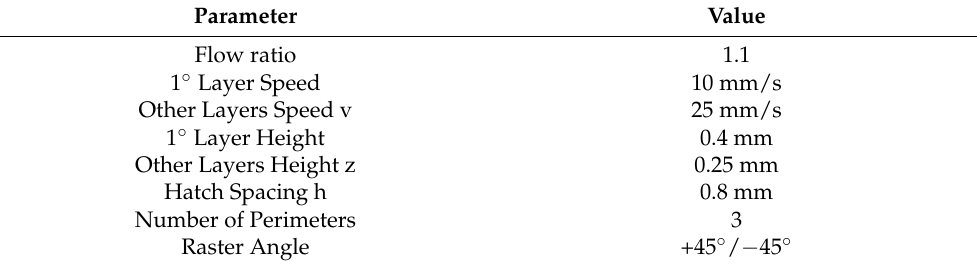
Table 2. Kinematic process parameters for a 0.6 mm nozzle